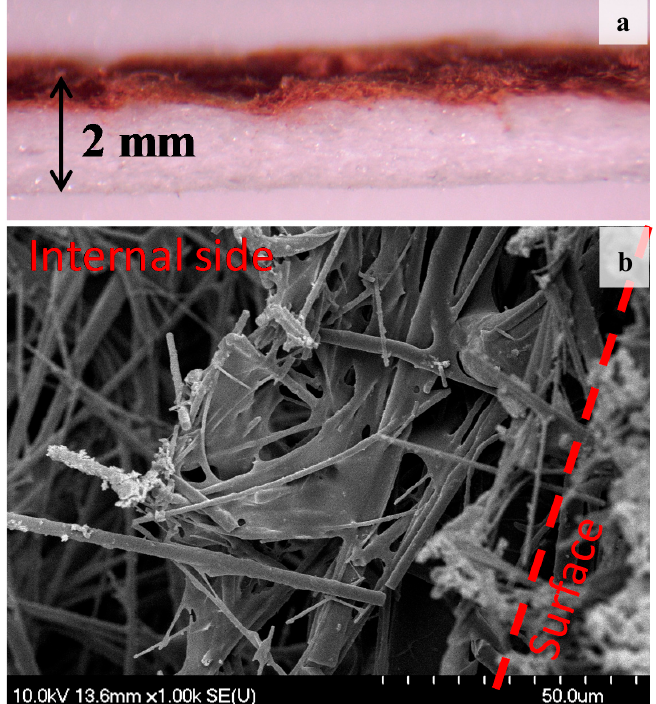
Figure 5. Distribution of the immobilized BiOI: Vertical optical image ( a ) and SEM micrograph ( b ) of the CP_MQ_s.c. two-step spray-coated ceramic paper.